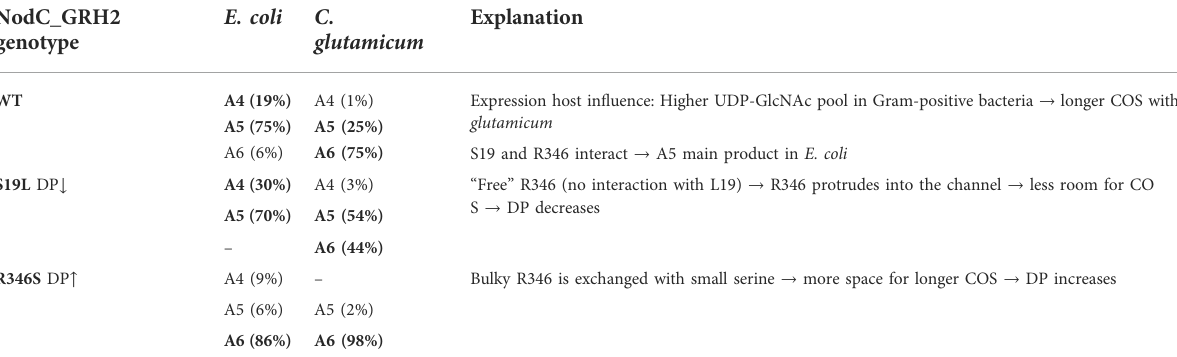
TABLE 3 Summary of the results. Given is the product range for each cultivation of E. coli/C. glutamicum expressing the wildtype or the mutein enzymes as well as a possible explanation. NodC_GRH2